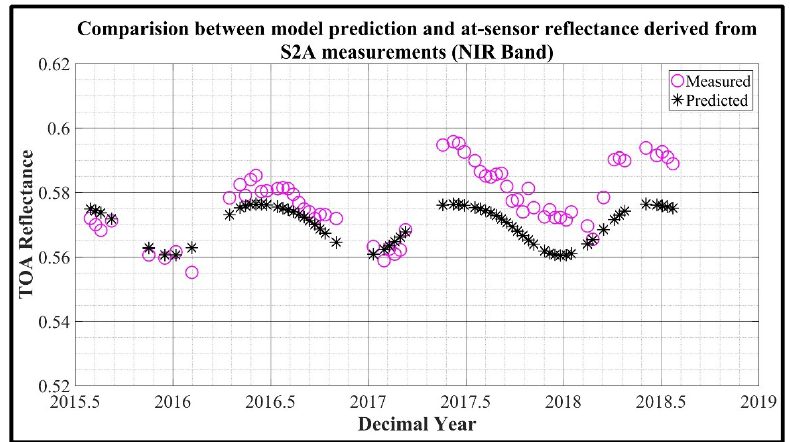
Figure 13. S2A MSI observation of Egypt 1(circle) and model prediction (asterisk).